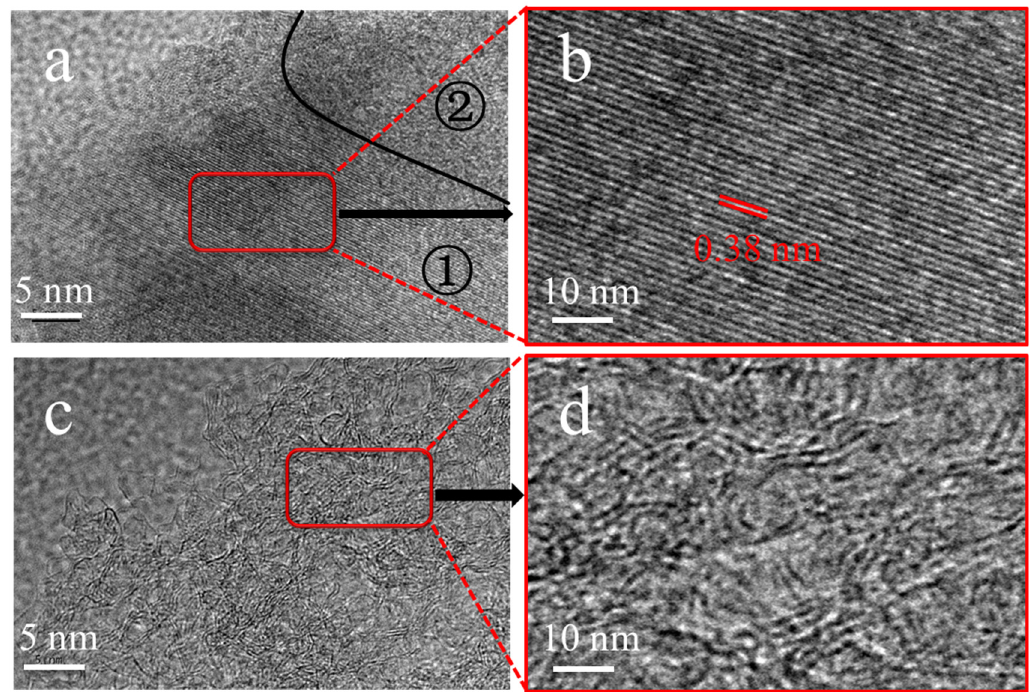
Figure 3. TEM images of ( a , b ) RH-900 and ( c , d ) Act-RH-900.